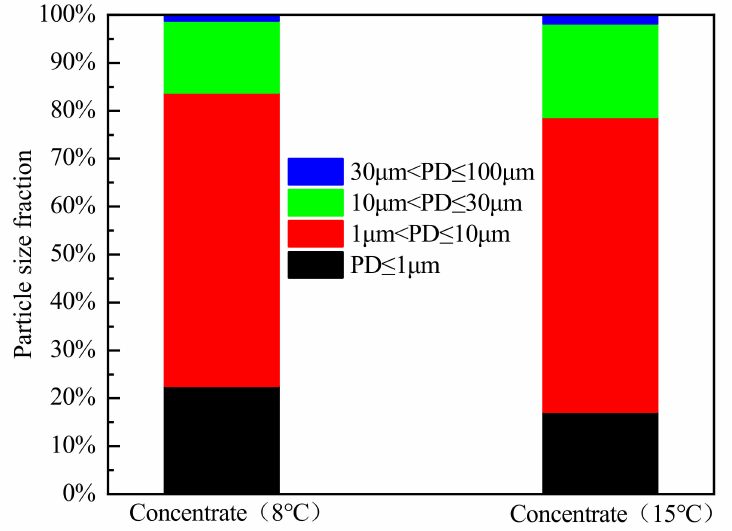
Figure 4. The proportion of particles in di ff erent particle size intervals in the concentrate at di ff erent